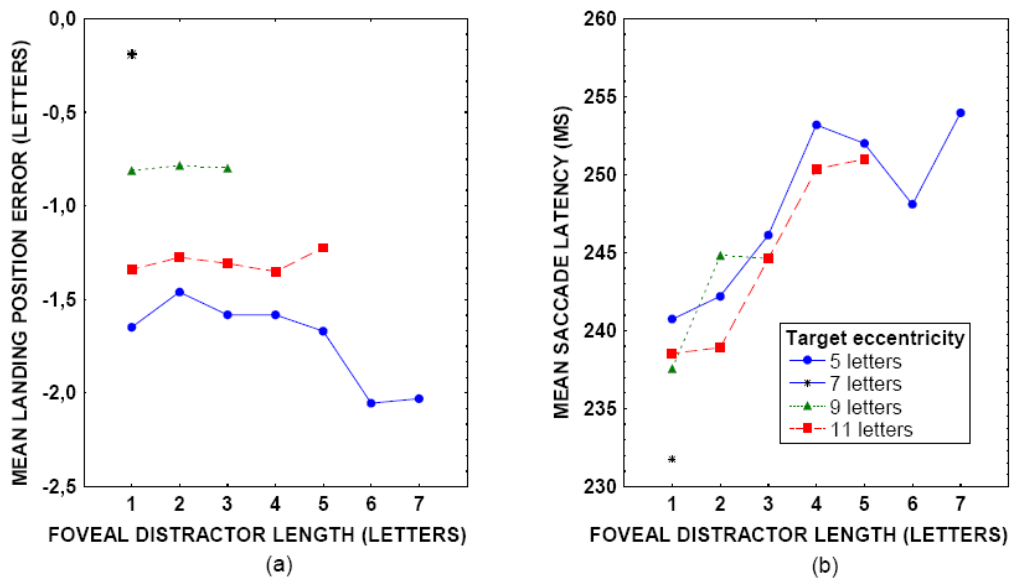
Figure 1. Re-plotted from Vitu et al.’s (2006) Experiment 1. Mean landing position error in letters (a) and mean latency in ms (b) of the initial saccade made towards the central letter of a 7-letter string (i.e.. ‘xxxkxxx’) as a function of the length of the foveal distractor string (an x-letter string of a variable number of letters) and the eccentricity of the target letter (5, 7, 9, or 11 letters).